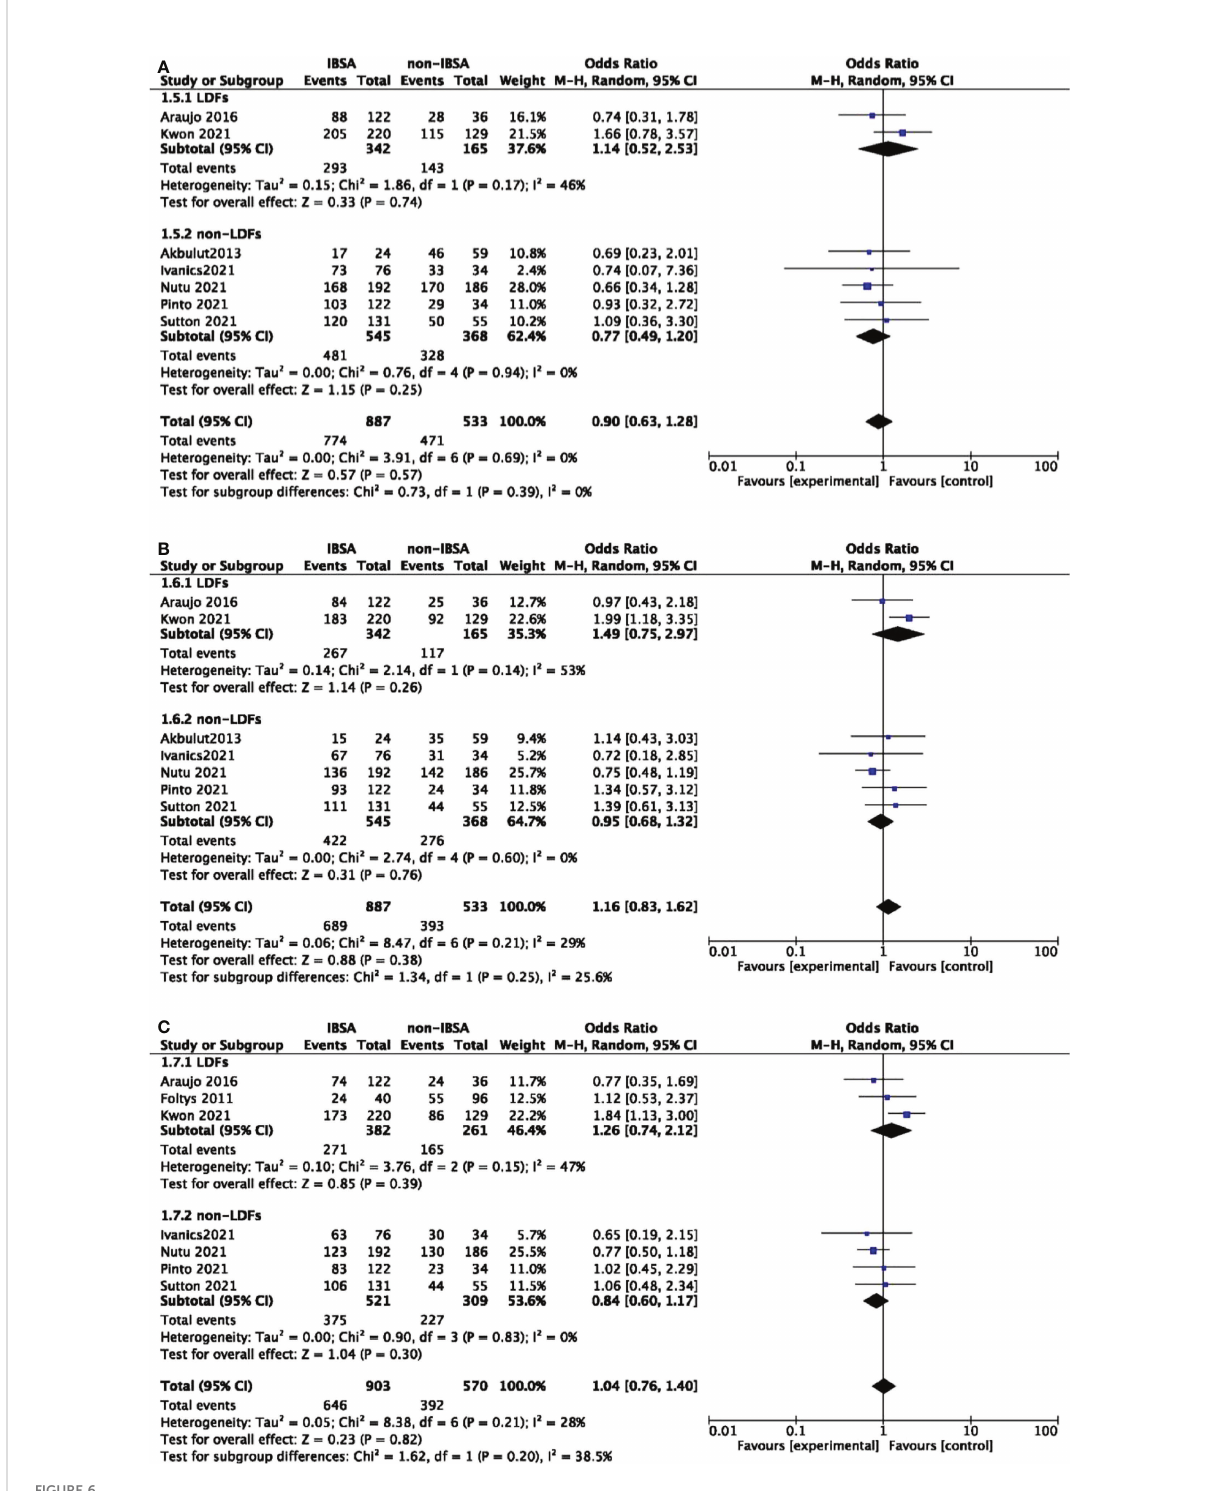
FIGURE 6 Meta-analysis forest plot of subgroup analysis of the overall survival. (A) , 1-year OS; (B) , 3-year OS; (C) , 5-year